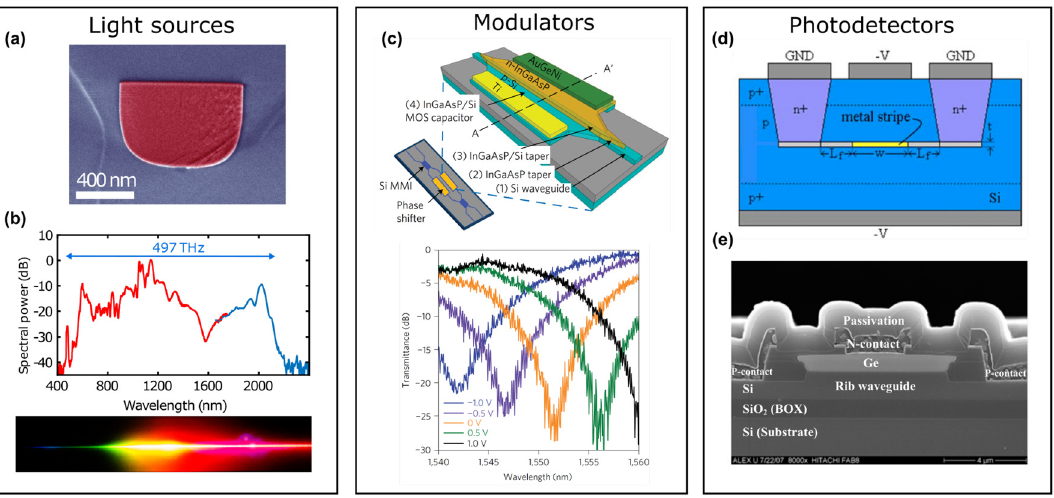
Figure3: Keyactivecomponentsinon-chipnanophotonics.(a)SEMimage(falsecolor)ofawaveguidefacetand(b)Supercontinuumspectrum generatedina 5.5mm longSi 3 N 4 waveguidewith h =1 μ m, w =0.8 μ m,and E p =590pJ withphotographof thespectrumafterbeingdispersed by a diffraction grating (reproduced from [57]). (c) Schematic of the InGaAsP/Si MOS capacitor MZ modulator (top) and Measured spectrum of an MZ modulator with 700- μ m-long phase shifter as a function of applied voltage (bottom) (reproduced from [58]). (d) Surface-plasmon Schottky contact detector based on a metal stripe buried in silicon (reproduced from [59]). (e) Cross-section SEM image of Ge waveguide photodetector (reproduced from [60]).